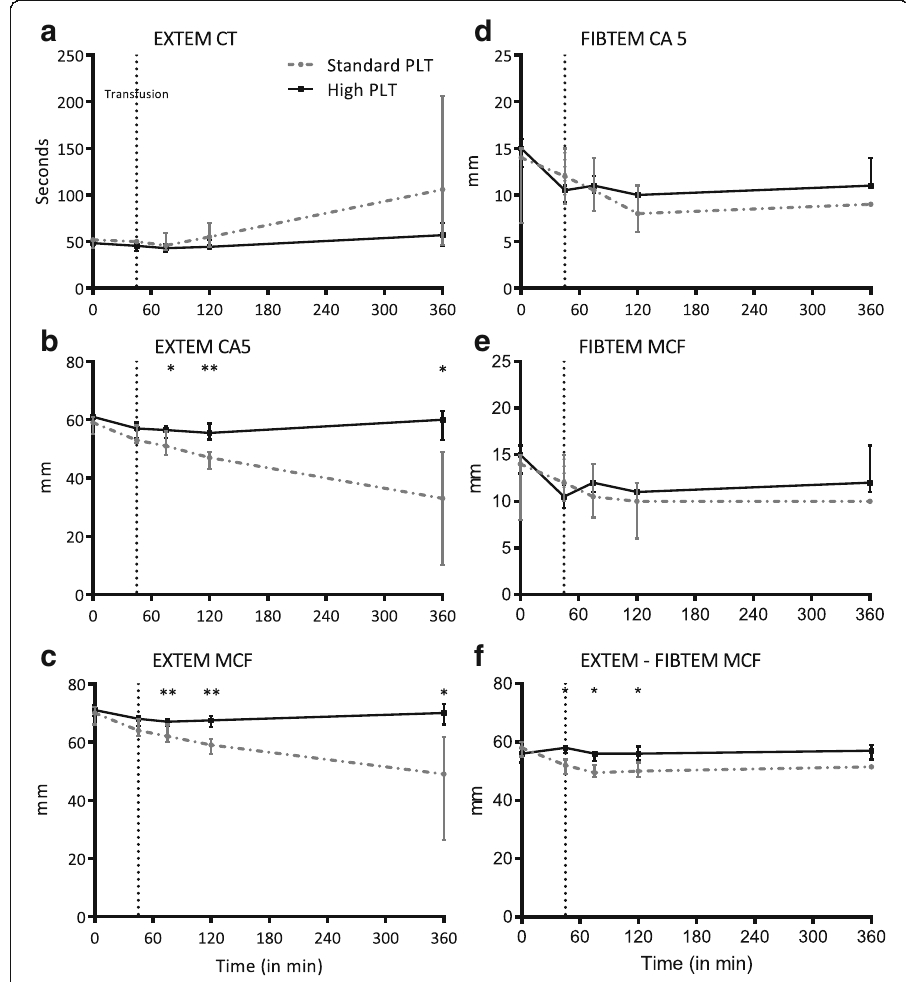
Fig. 2 ROTEM assays. Data are presented as median (IQR). a EXTEM CT. b EXTEM CA5. c EXTEM MCF. d FIBTEM CA5. e FIBTEM MCF. f EXTEM - FIBTEM MCF. PLT platelet transfusion, CT clotting time, CA5 clotting amplitude at 5 min, MCF maximum clot firmness. Dotted vertical line at 45 min represents initiation of resuscitation. * p < 0.050, ** p < 0.001 between Mortality Mortality rate in this experiment was 19%, with all deaths occurring in the standard PLT dose group. One rat died during induction of anesthesia and was excluded from all analyses. The remaining rats in the standard PLT dose group reached our primary outcome, therefore these rats were incorporated in our primary outcome analysis. Two rats died during the course of the experiment, of which one rat died 30 min prior to planned termination of the experiment. The last-mentioned animal was included in all